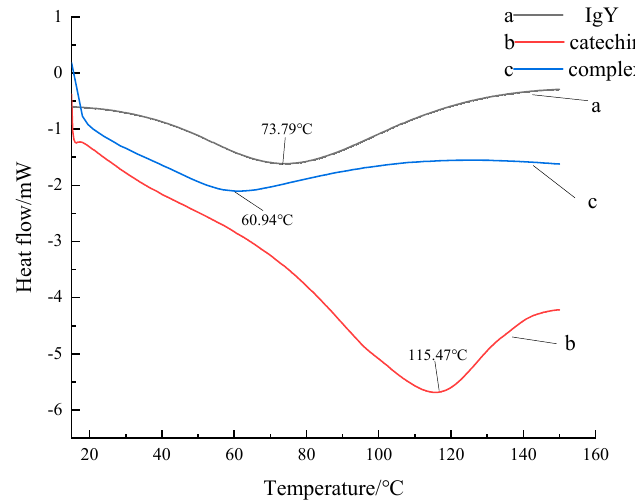
Figure 9. Differential scanning calorimetry analysis.